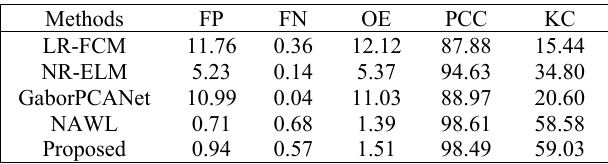
Table 1. Results (%) and comparison of various methods on Yamenkou dataset.